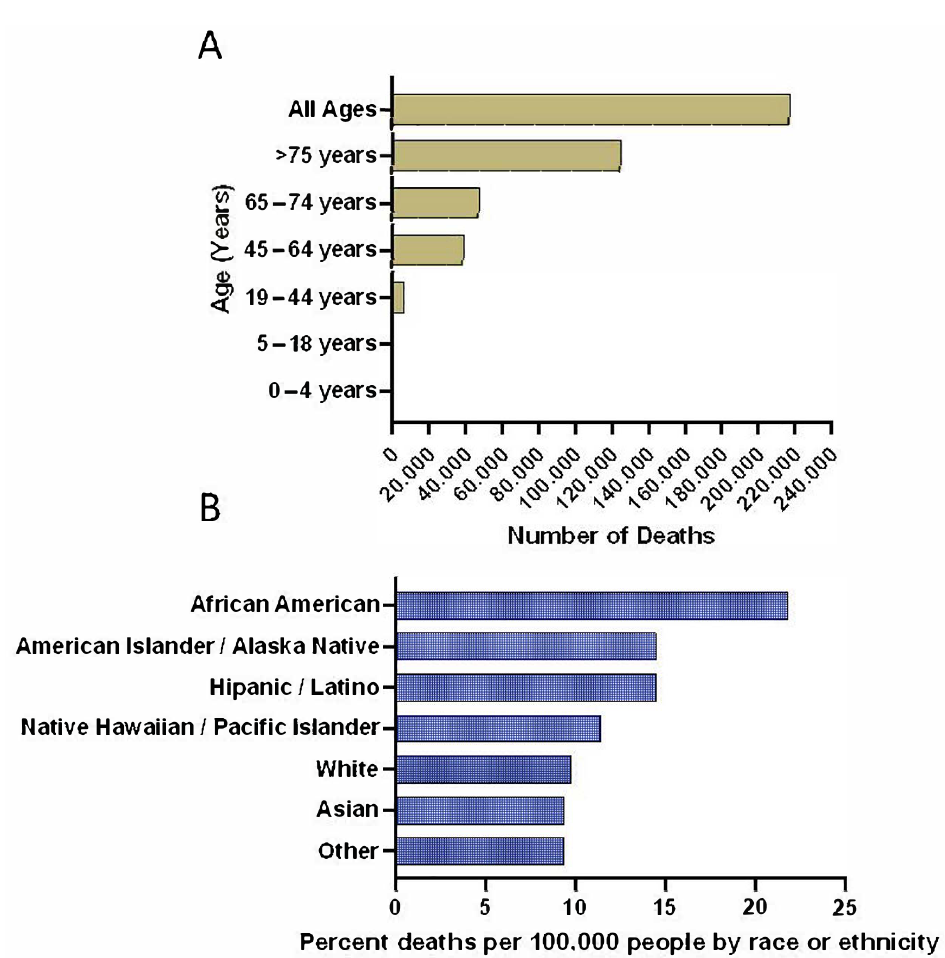
Figure 1. Cumulative confirmed cases of COVID-19 in United States as of November 4, 2020. The number of confirmed COVID-19 deaths by age ( A ) [12], and the number of confirmed COVID-19 deaths by race and ethnicity ( B ) [22] are